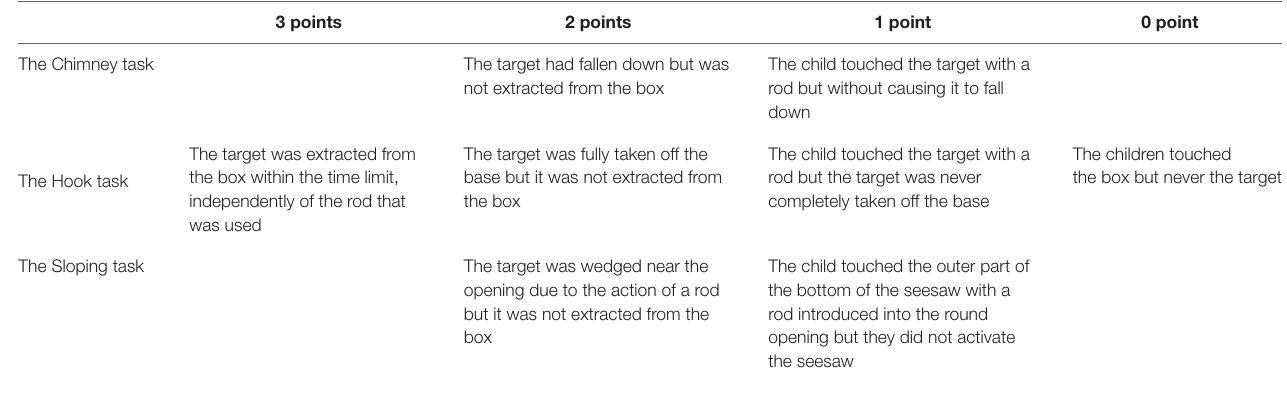
TABLE 1 | Accuracy-based scoring system used for mechanical problem solving